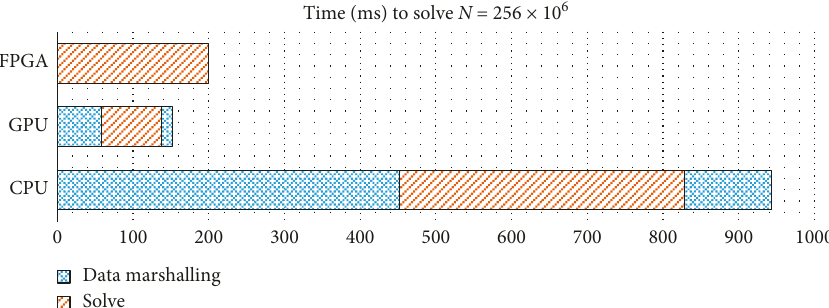
Figure 6: Time (ms) to solve a system of size N � 256 × 10 6 using oclspkt , targeting CPU, GPU, and FPGA